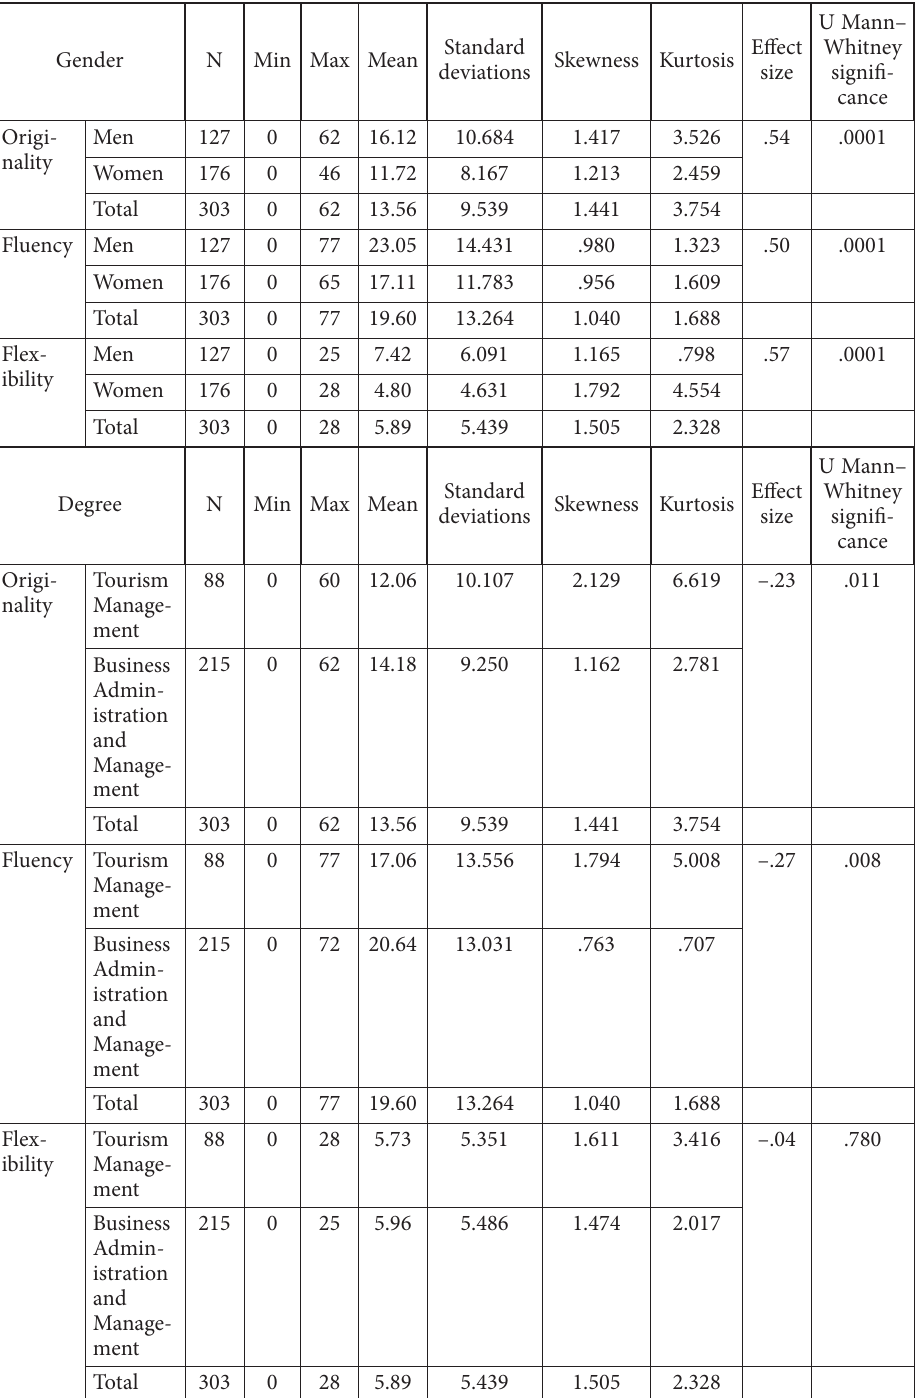
Standard Skewness Kurtosis deviations